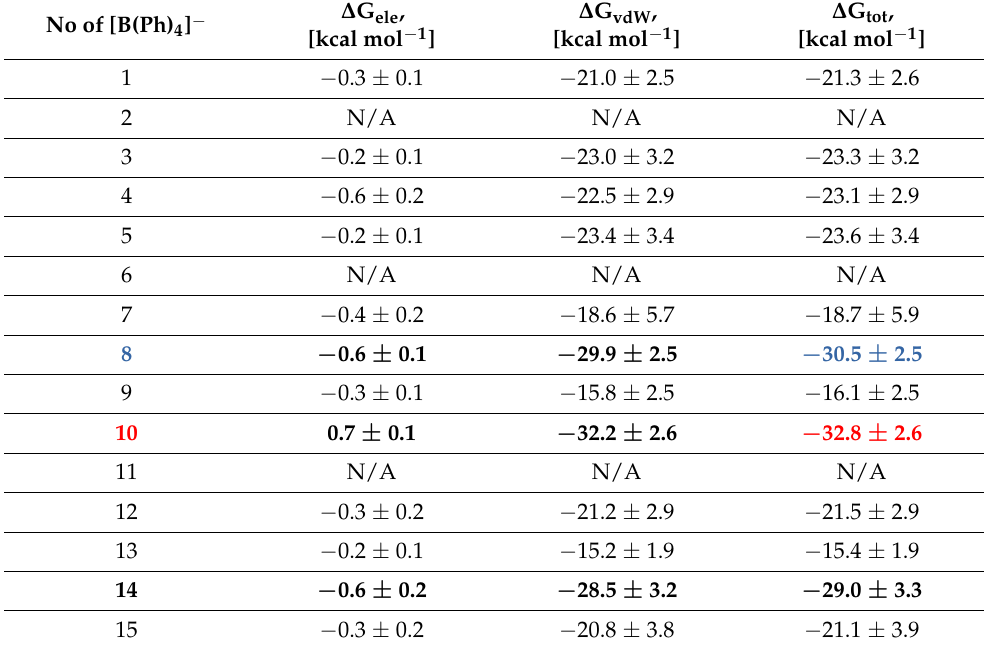
Table 4. LIE free-energy decomposition values for [B(Ph) 4 ] − ligands in the [B(Ph) 4 ] − –BSA complex. Three [B(Ph) 4 ] − ions (no 2, 6 and 11) did not form stable complexes with BSA throughout the simulation. ∆ G ele , ∆ G vdW and ∆ G tot correspond to the electrostatic component, van der Waals component and total energy,